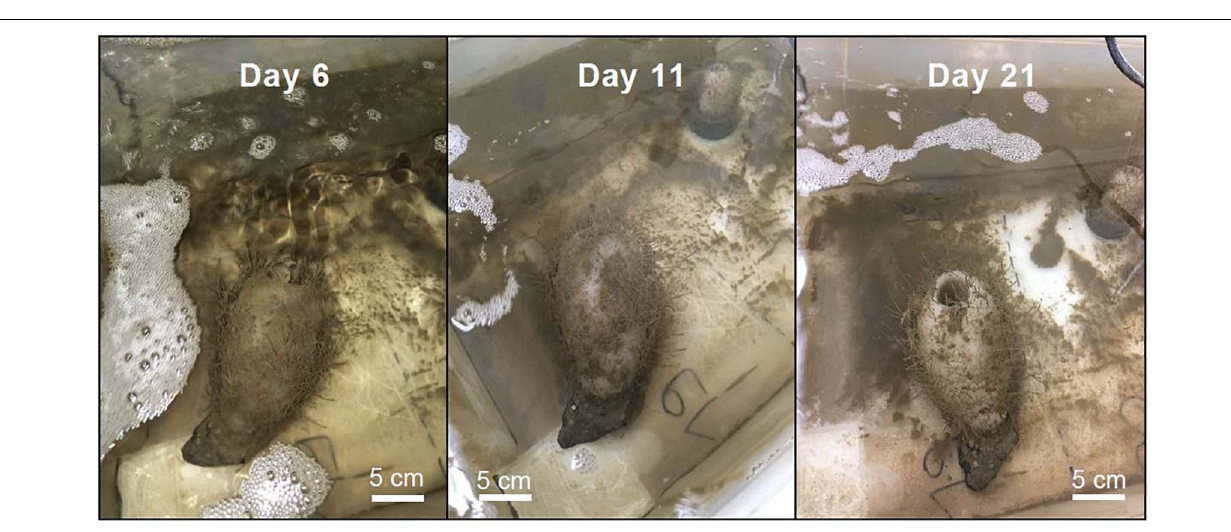
FIGURE 10 | Succession of recovery of a sediment-exposed sponge at 6, 11, and 21 days after sediment exposure stopped. This sponge was sampled for SEM/EDS analysis 38 days after sediment